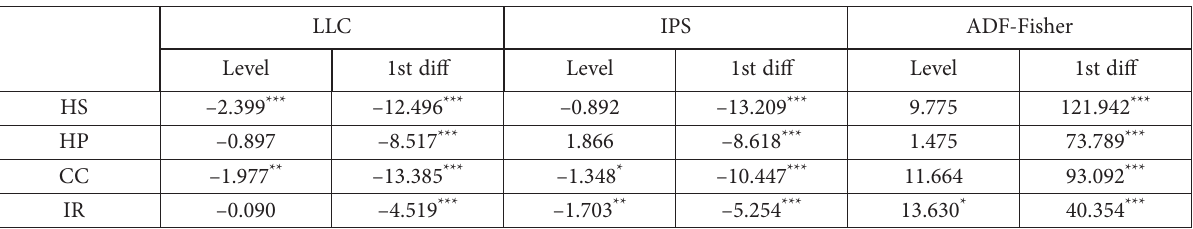
Table 2. Panel unit root test